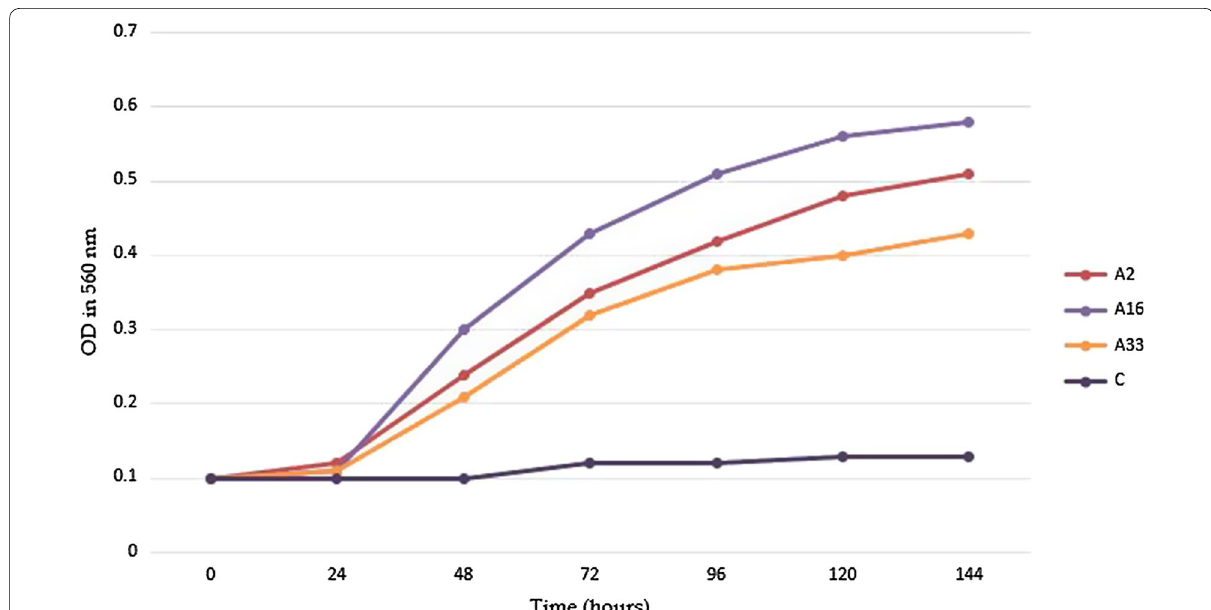
Fig. 6 Growth curves of Iranian isolates of mycobacteria over a 24 h. Incubation period at 30 °C in the presence of sodium